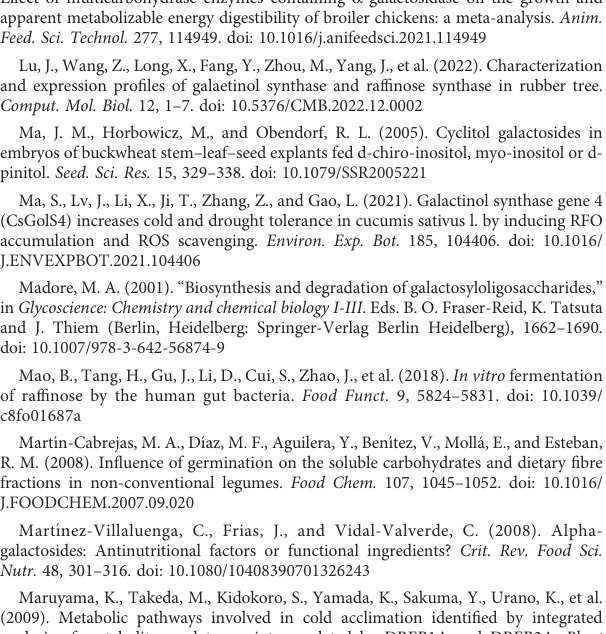
raf fi nose family oligosaccharide metabolic pathways in rice. Rice 15, 34. doi: 10.1186/